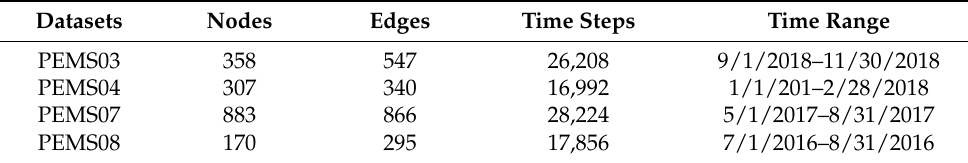
Table 1. Datasets